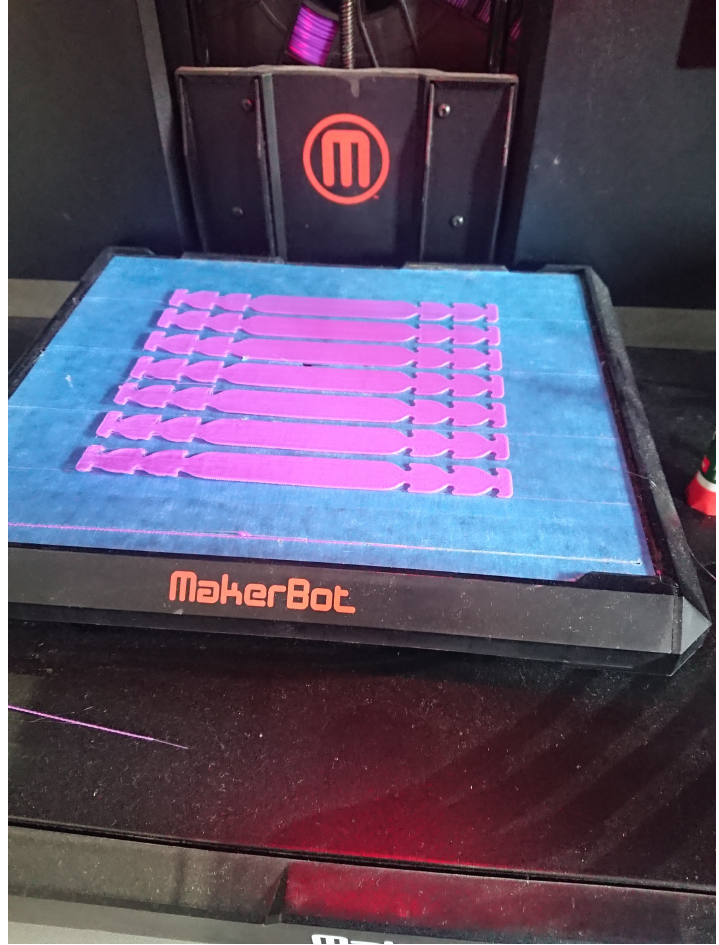
Figure 2. Example 3D printed mask extender set, or earsaver, manufactured to support local hospital needs on a desktop-style 3D printer. Design: disposable ear relief strap [56]. Machine: MakerBot Replicator. Material: polylactide